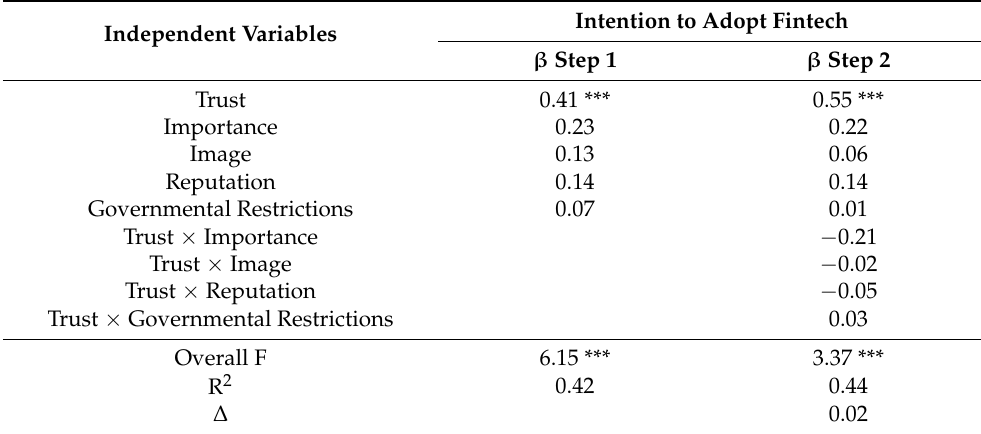
Table 10. Moderating effect of environmental context on the relationship between perceived trust in Fintech services and intention to adopt the Fintech service (Source—IBM SPSS Statistics v.28.0.0).